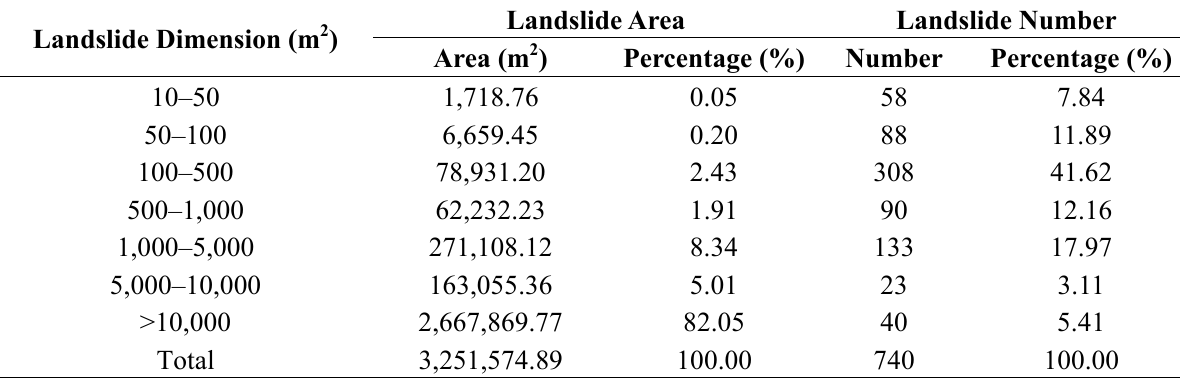
Table 2. Extracted landslide statistics in the research